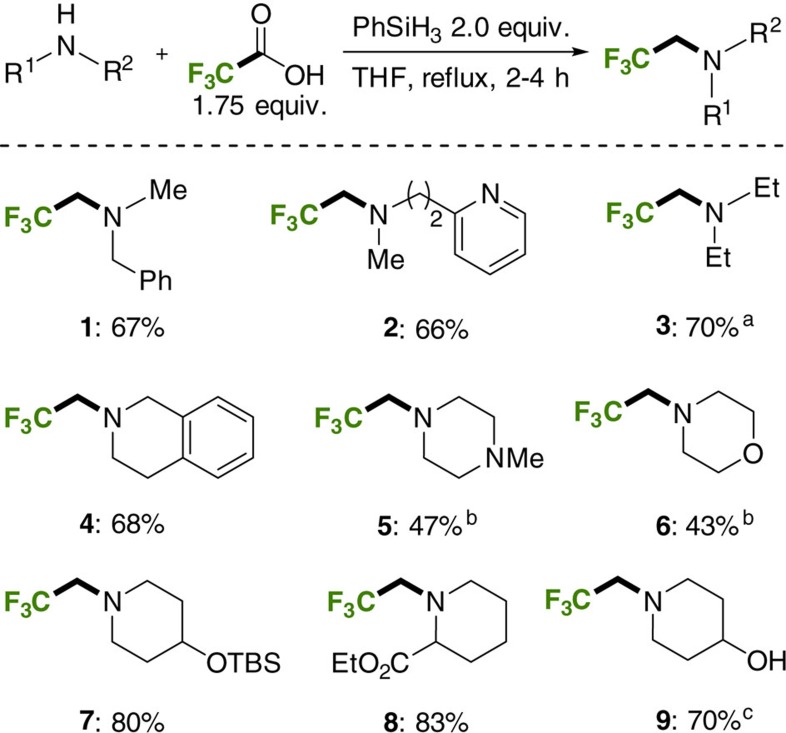
Trifluoroethylation reactions of secondary amines.Isolated yields following chromatography. aIsolated as its HCl salt following aqueous work up. bProduct is volatile. cThe reaction was quenched with 1 M NaOH to desilylate the hydroxyl group (THF, tetrahydrofuran; TBS, tert-butyldimethylsilyl).